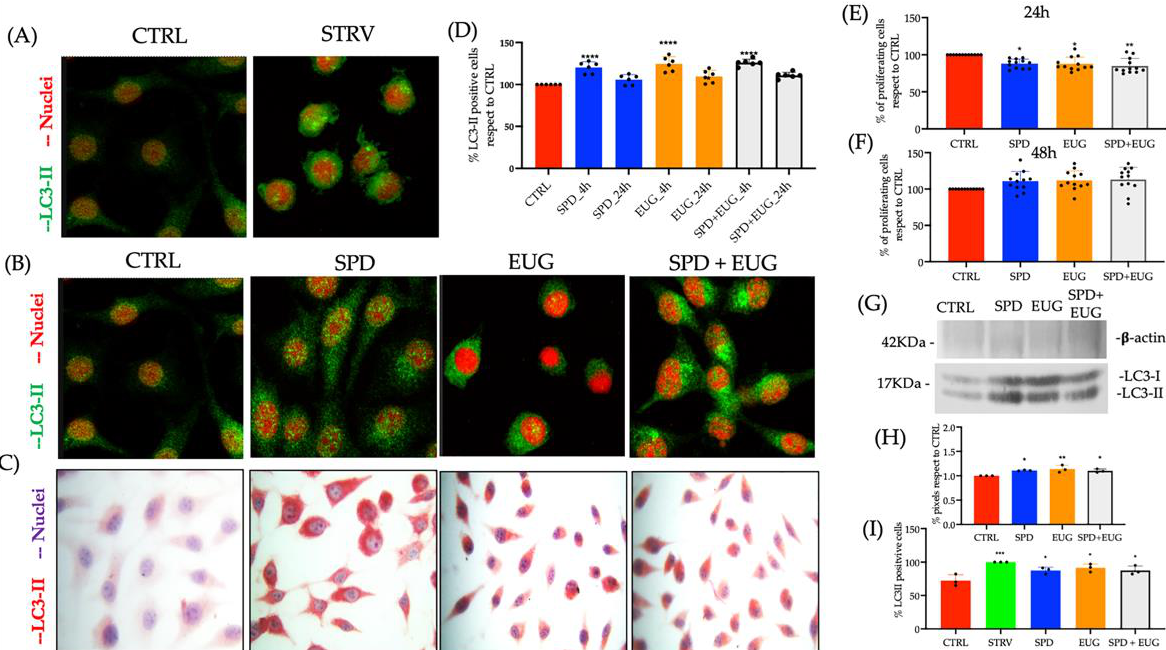
Figure 2. The effect of 0.3 mM spermidine (SPD) and 0.2 mM eugenol (EUG), alone and in combination (0.3 mM SP + 0.2 mM EUG) on LC3-II activation and cell viability in L929 ( A – H ) and U937 ( I ) cell lines. ( A ) LC3-II in the untreated control and the starvation (STARV)-induced control was detected with immunofluorescence green staining (FG) after 4 h. ( B , C ) For the SPD, EUG and SPD + EUG treatments, LC3-II was detected with FG staining and red chromogen staining. ( D ) Statistical analysis of the LC3-II positive cells stained with red chromogen was performed after both 4 h and 24 h from the start of all treatments. Viability (MTT assay) of the cells after a ( E ) 24 h exposure and a ( F ) 48 h exposure to the treatments. ( G ) Western blotting of LC3-II with respect to β -actin was performed on L929 cells that were untreated or treated with SPD, EUG and SPD + EUG and the pixels quantified (H). (I) Quantification of LC3-II positive cells of U937 stained with FG after 4 h following starvation, SPD, EUG and SPD + EUG treatments. The number of stars *, **, *** and **** represents significant differences between treatments as determined by one-way ANOVA at the 99% confidence level ( p < 0.01). The black dots indicate the positioning of the individual replicates within the bar for each sample.